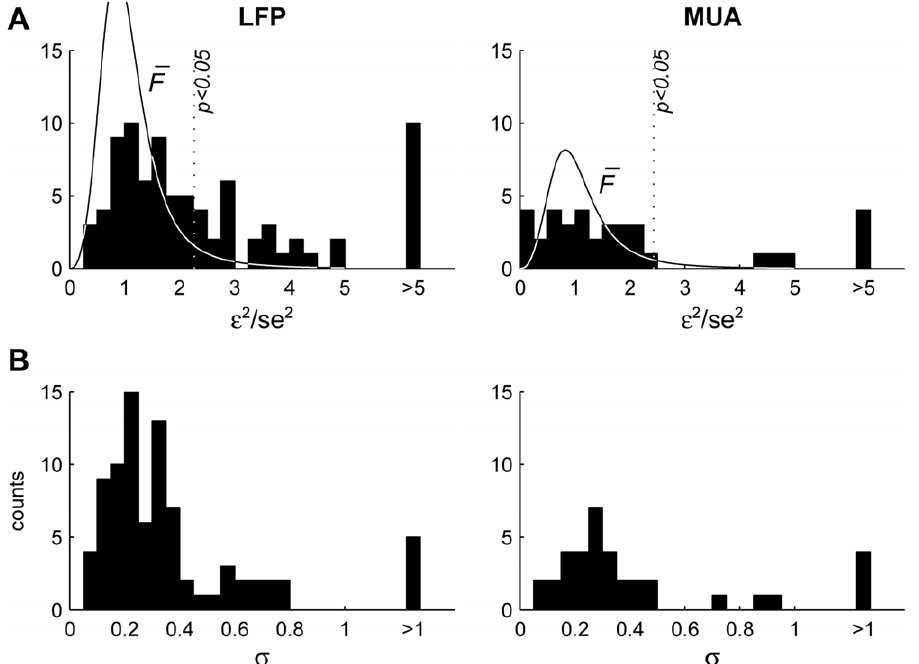
Figure 11. Model error and half-width of the adaptation channel. A. Distribution of the sum of squared errors between responses and fitted values, divided by the sum of squared s.e.m of the responses. The terms of both sums were weighted by the square root of the number of presentations of the corresponding stimulus. For comparison, the thin line indicates the average of the F(n,n) distributions associated with each of the sites, where n, the number of degrees of freedom, is the number of responses that were fitted by the model at that site. Vertical dotted line - the 0.05 critical value of the average F distribution. The majority of the models (51/84 of the models fitted to LFP responses, 61%, and 28/69 of those fitted to MUA responses, 81%) had an error ratio below this limit. B. Distribution of the half width of the adaptation channel, s , in all recording sites at which the fitting procedure converged successfully. doi:10.1371/journal.pone.0023369.g011 PLoS ONE |